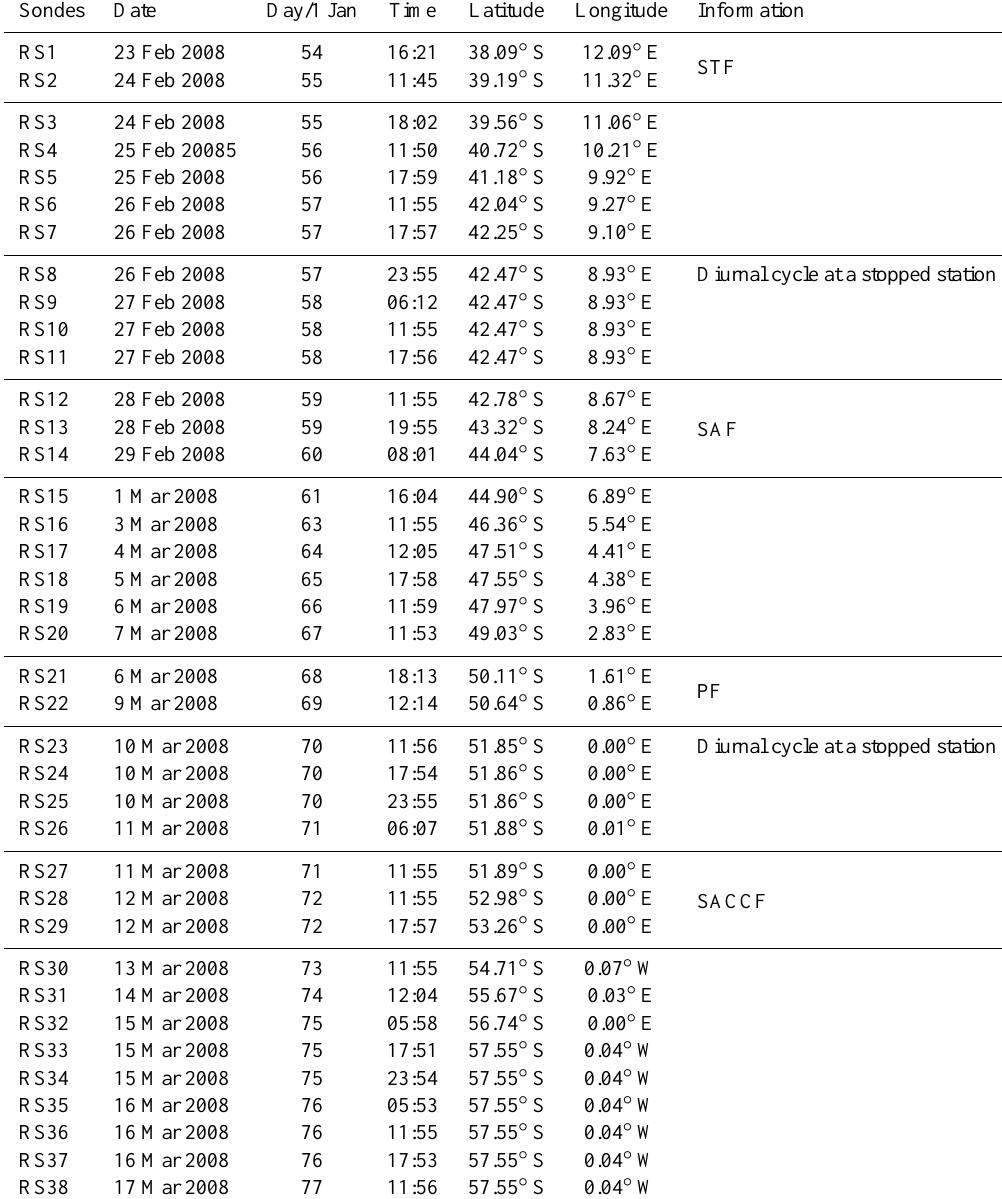
Table 2. Times and locations of the 38 radiosondes